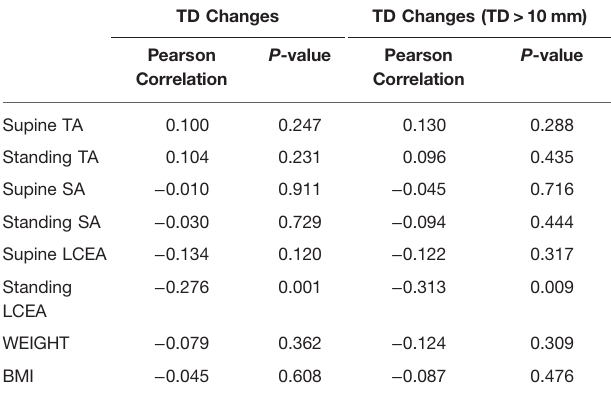
TABLE 1 | TD difference between supine and standing positions.